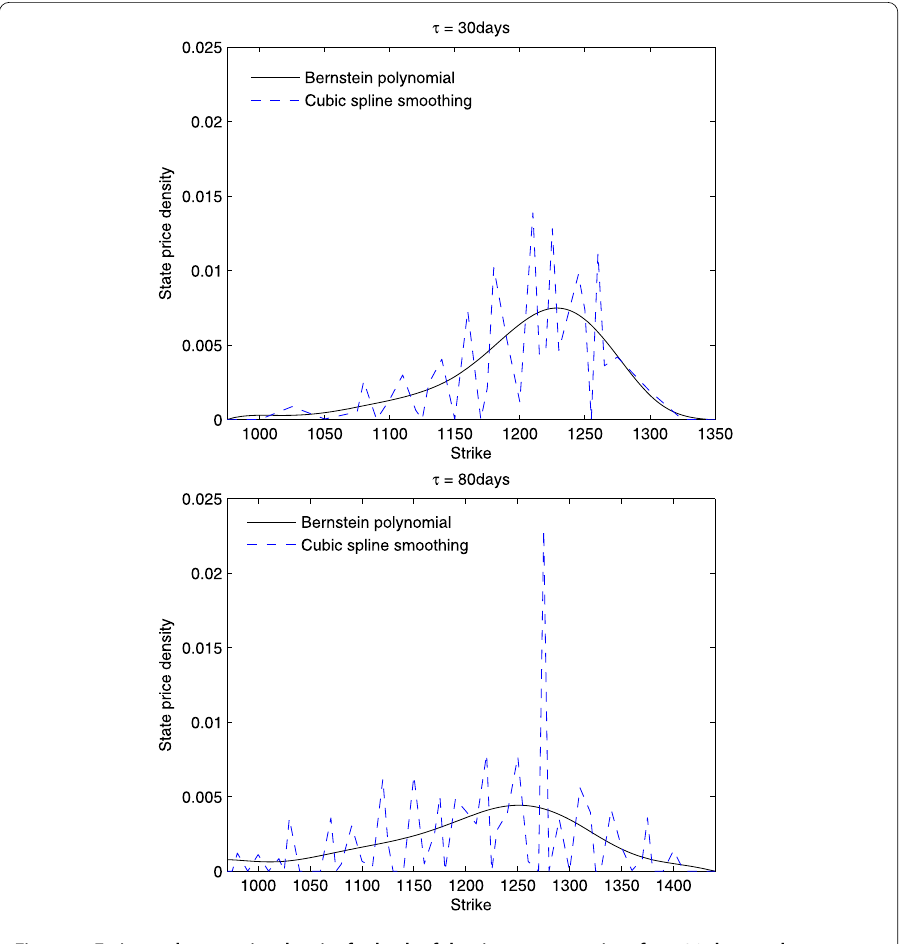
Figure 7 Estimated state price density for both of the times to maturity of τ = 30 days and τ = 80 days,